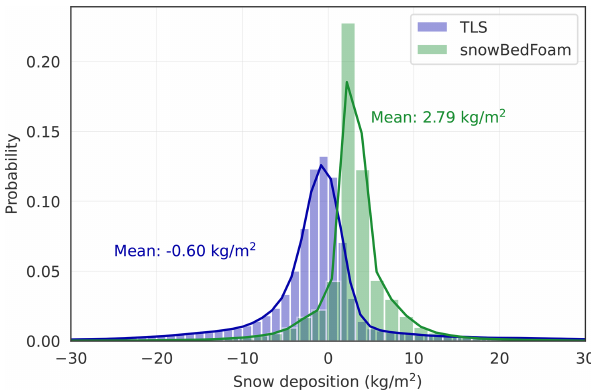
Figure 7. Statistical distribution of snow deposition (kgm − 2 ) for the combined extrapolated snowBedFoam 1.0. simulation results (green) and the terrestrial laser scan measurements (blue). The av- erage snow mass change values for TLS and OpenFOAM are dis- played in the corresponding